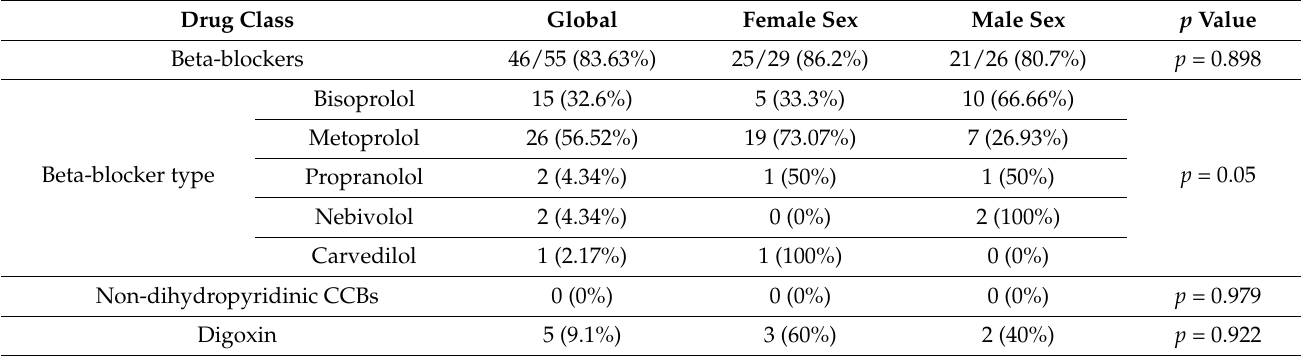
Table 4. The main therapeutic classes administered for heart rate control, both in the general population and according to the patient’s sex.